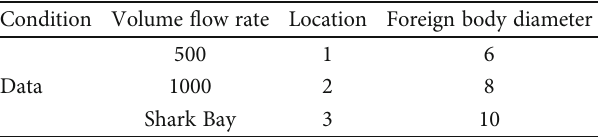
Table 2: Simulation scheme.